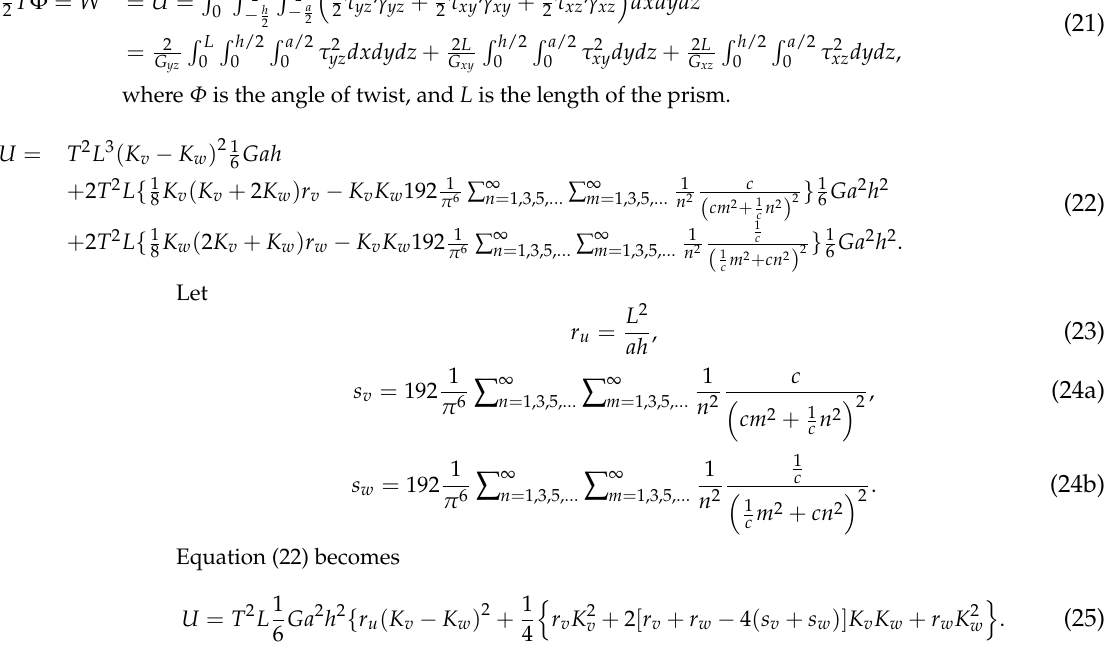
, 1 , J and J T verse aspect ratio c , c = h / a 1 1 2 k v 2 k w 2 h 2 2 h 2 3 a 3 a